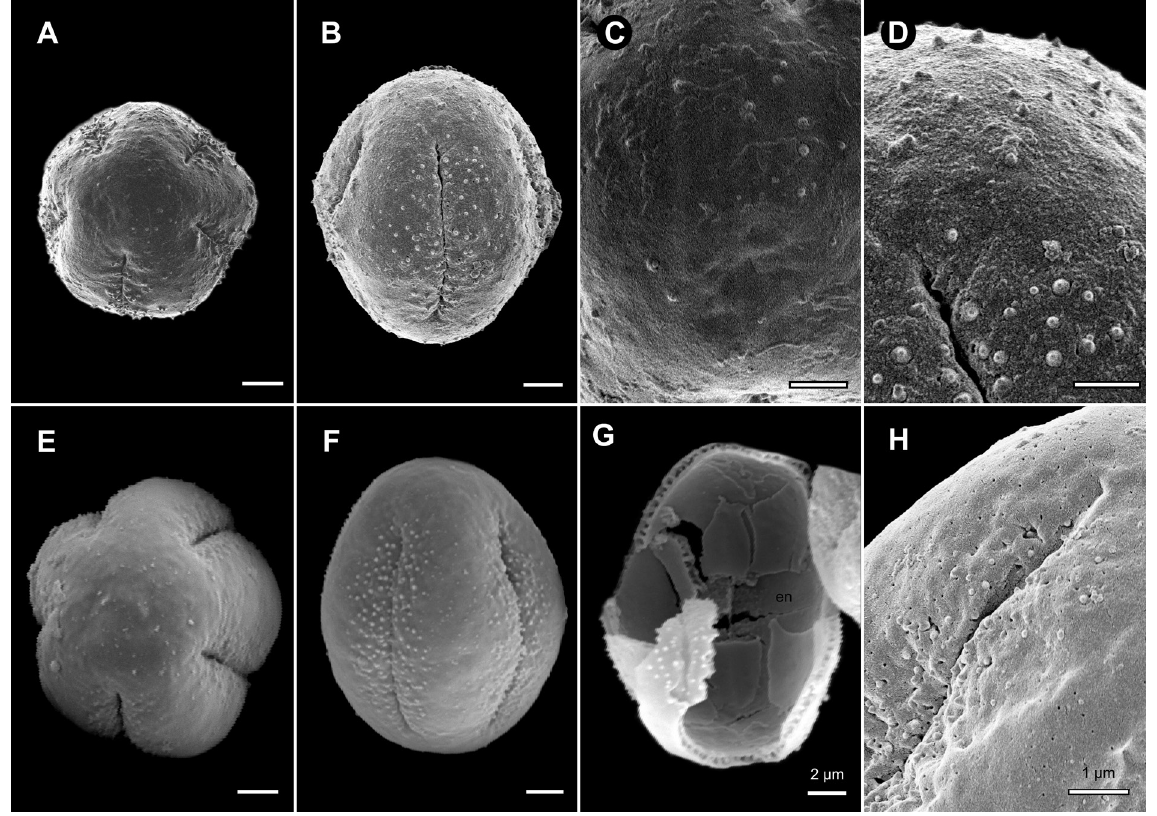
Fig. 5. Pollen morphology (SEM). A–D . Psyllocarpus itakangapyra Sobrado, J.A.M.Carmo & R.M.Salas sp. nov.; P.L. Viana et al. 441 5 (CTES). A . Polar view. B . Equatorial view. C . Detail of apocolpium. D . Detail of the colpus and spinules. E–H . P. vianae Sobrado, J.A.M.Carmo & R.M.Salas sp. nov.; P.L. Viana et al. 5887 (CTES). E . Polar view. F . Equatorial view. G . Detail of the inner side of a pollen fragment showing the endocingulum (en). H . Detail of the colpus and spinules. Scale bars: A–B, E–G = 2 µm; C–D, H = 1